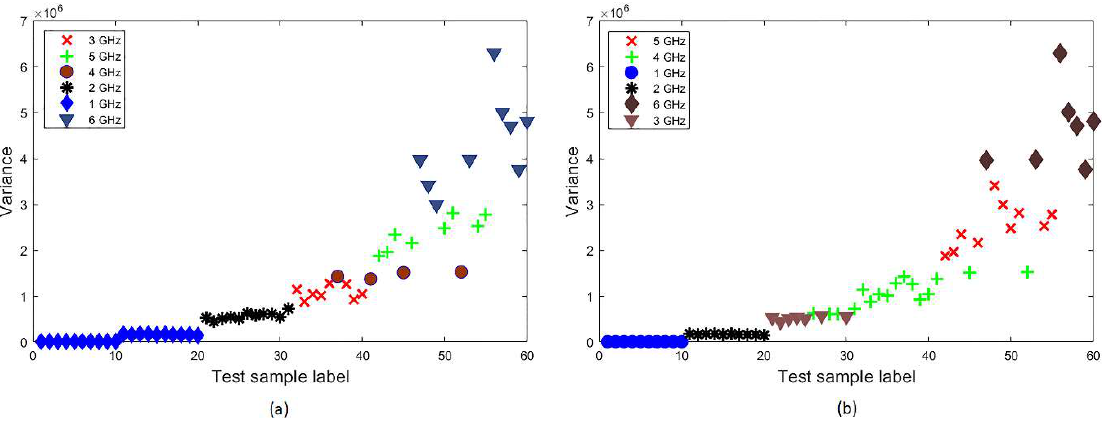
Table 2. Accuracy for classifying interference using MGRNN and GRNN.